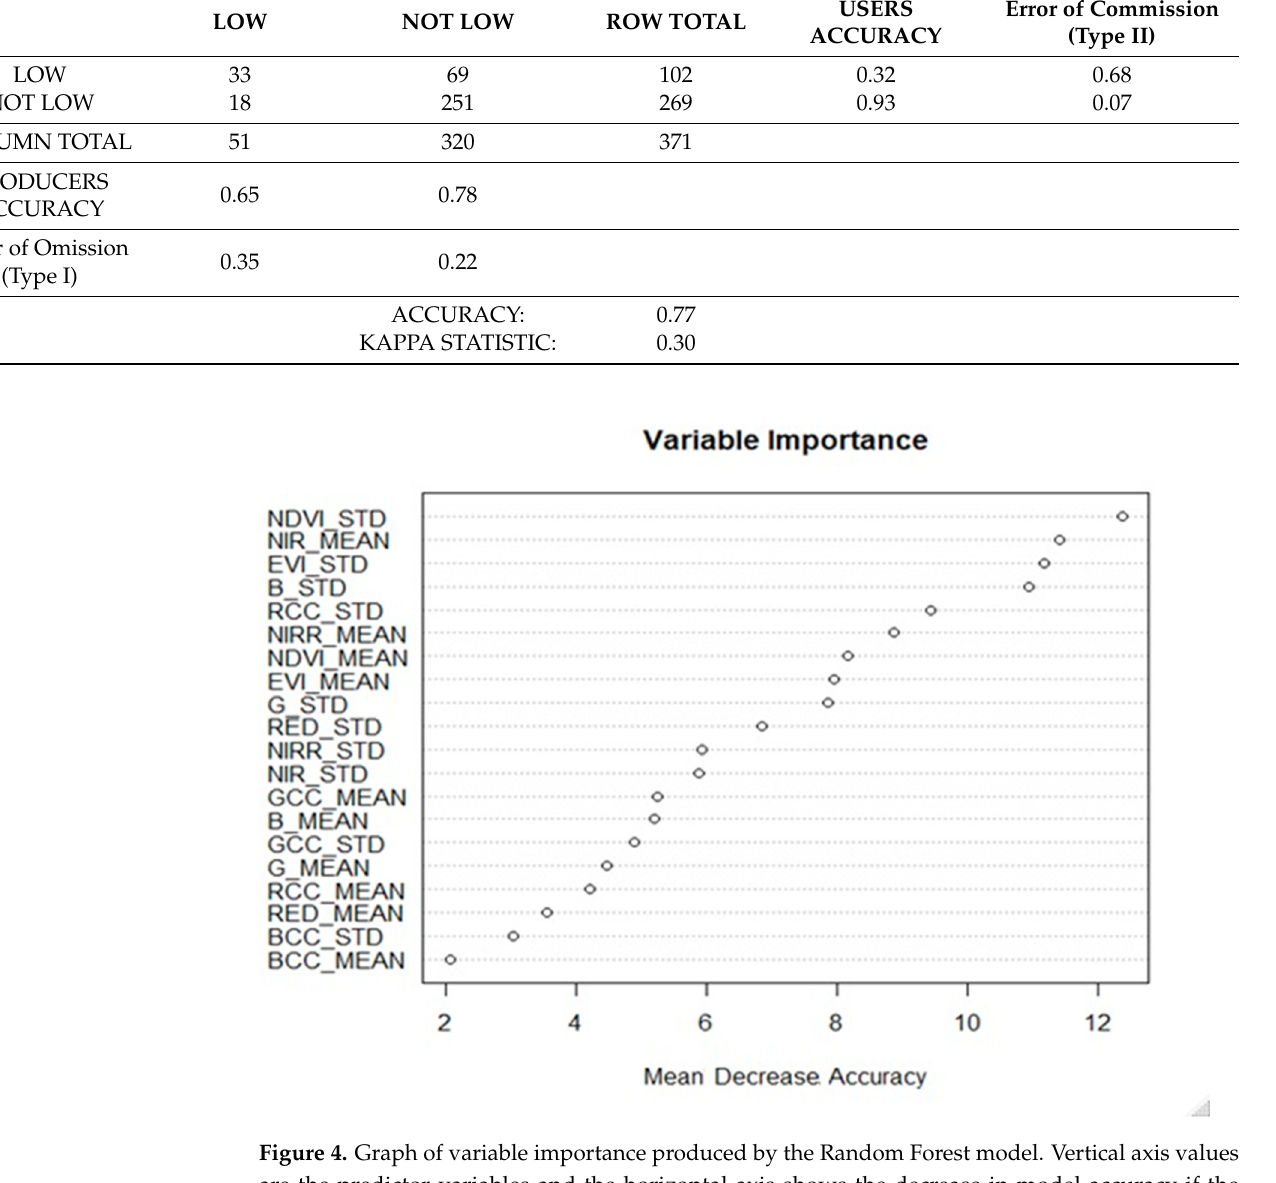
Table 6. OOB (out of bag) error matrix for the Random Forest model vigor predictions for all ITCs (individual tree crowns, outliers removed). The columns are the crowns as predicted by the model and the rows are the vigor assessments made in the field (reference data). The overall accuracy of 0.78 is calculated as the number of correctly classified crowns divided by the total number of crowns. The KAPPA statistic is the overall accuracy adjusted for random correct classification.